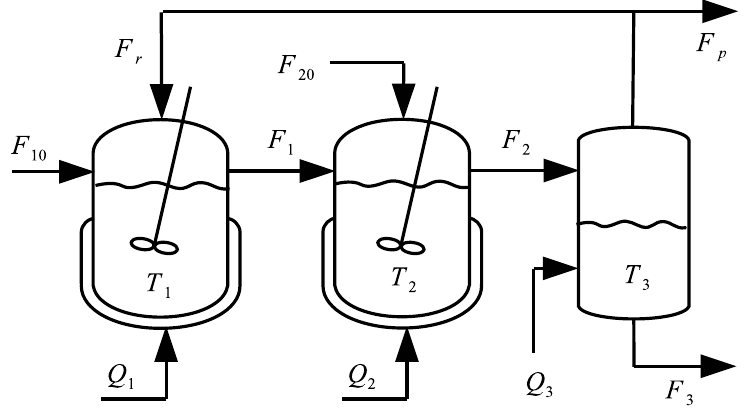
Figure 1. Reactor-separator process with a recycle